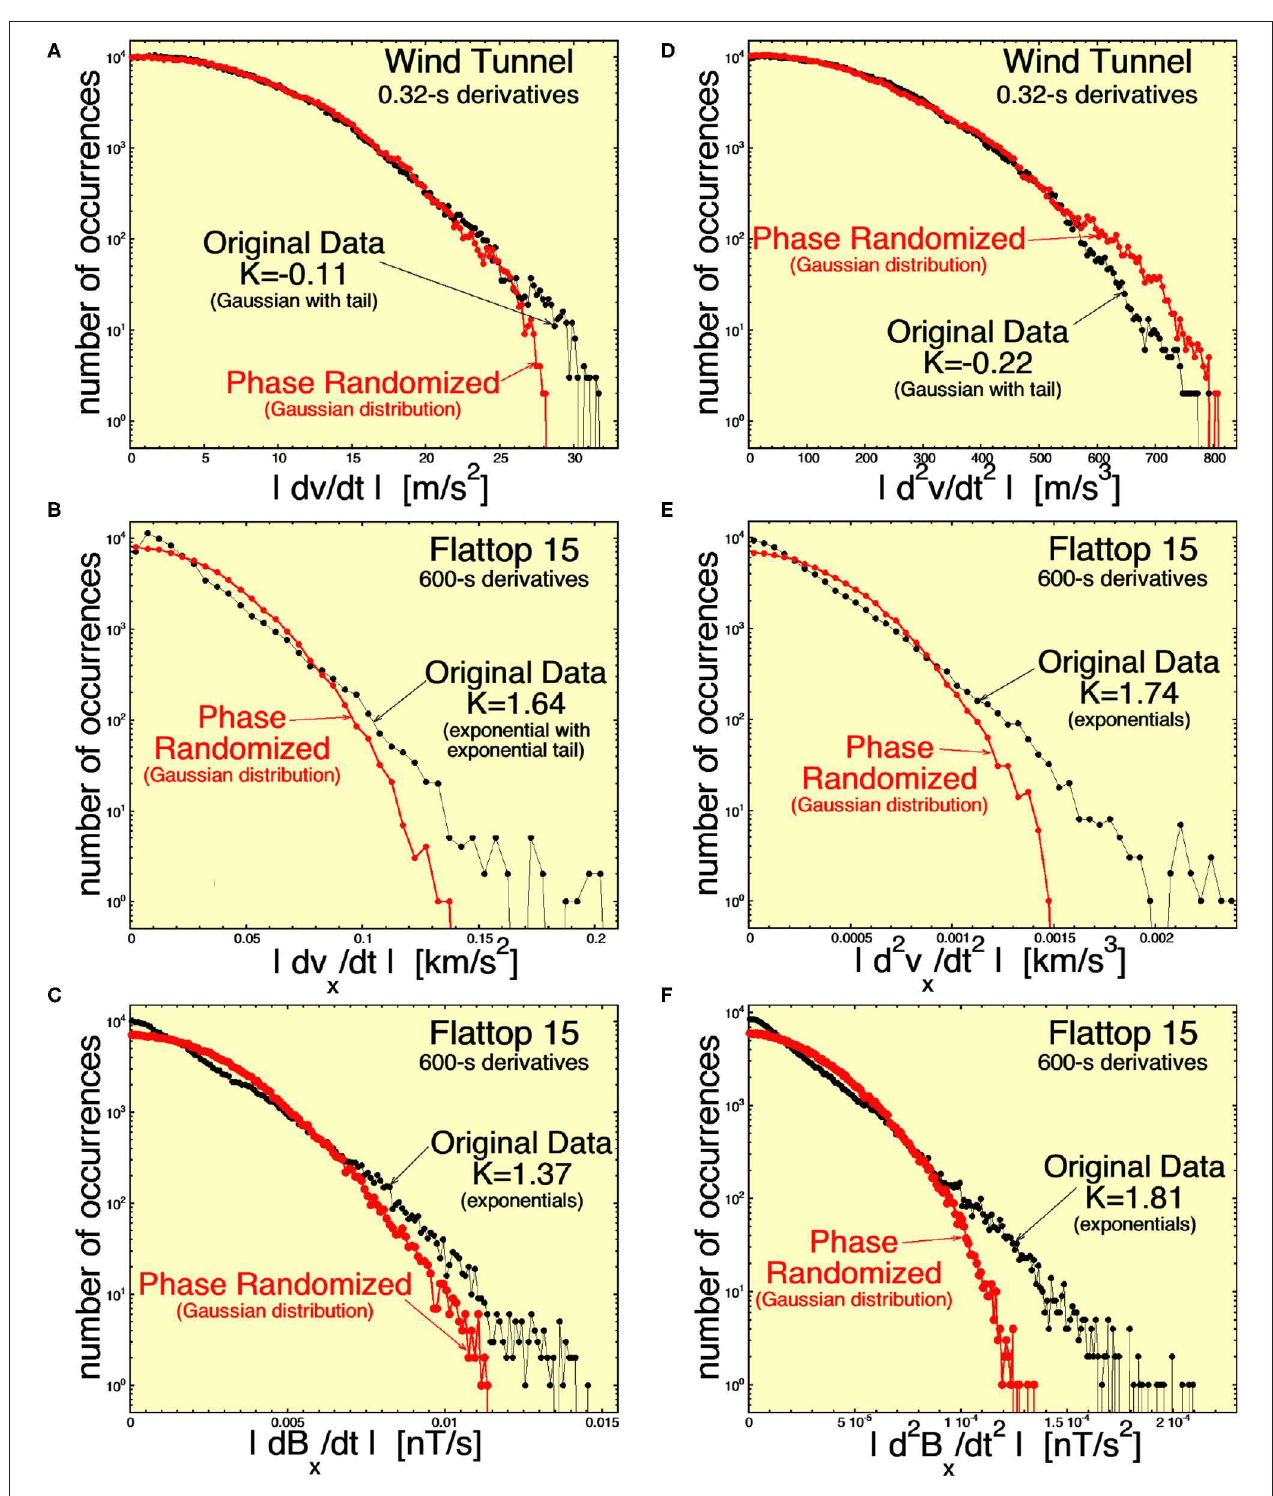
FIGURE 9 | Similar to Figures 6 , 8 , distributions of the measured first time derivatives (A–C) and second time derivatives (D–F) for (A,D) the streamwise velocity v in the wind tunnel Navier–Stokes turbulence (B,E) the radial (from the Sun) velocity v x for the Alfvénic solar wind fluctuations of Flattop 15, and (C,D) the radial component of the magnetic field B x for the Alfvénic solar wind fluctuations of Flattop 15. The black curves are time derivatives in the measured time series, and the red curves are time derivatives in phase-normalized versions of the measured time series. Here time derivatives are over a timescale a factor of 100 longer than in Figure 6 . For the original-data distributions, the kurtosis K of the signed values is noted.